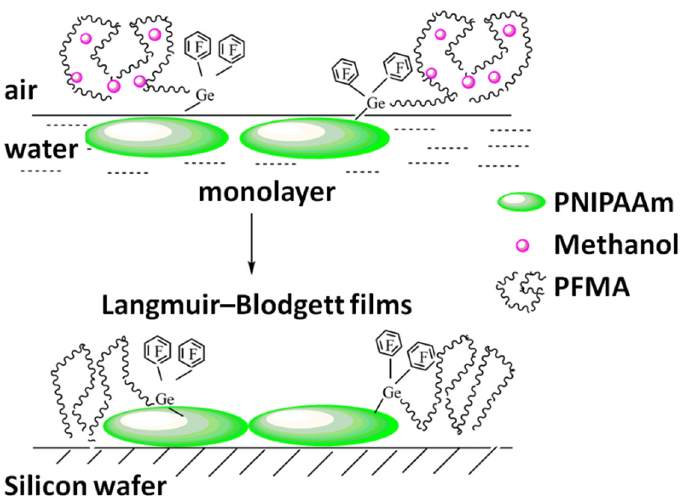
Scheme 3. Orientation macromolecules of block copolymer in monolayer and LB film (at pH = 7.0).